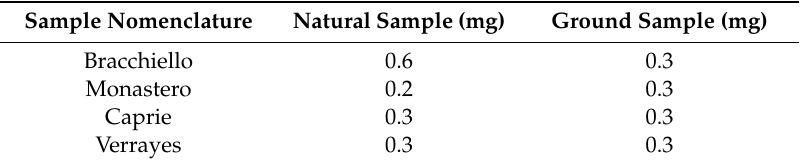
Table 2. Amount of material on the microscopic slide for each sample.